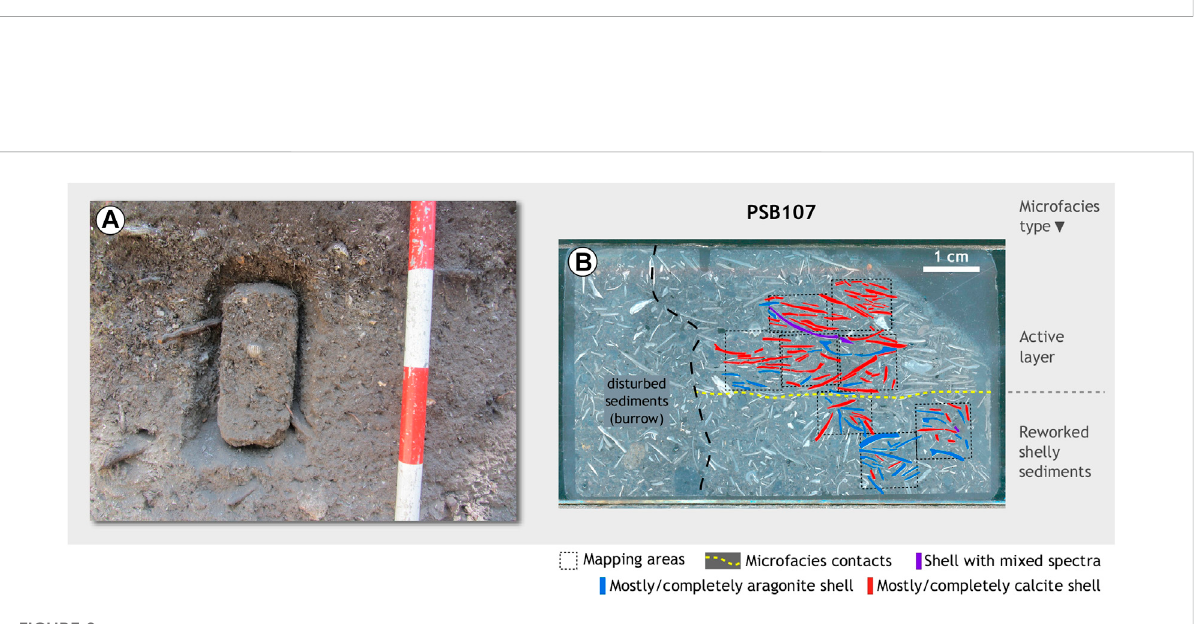
FIGURE 9 Sample PSB107. (A) Field photograph of the sample in pro fi le, prior to block extraction; note the general homogeneity that the shelly deposit exhibitsinthe fi eld,thoughdifferentdepositionalandpostdeposionaleventsarerevealedbymicrostratigraphyandmineralogy. (B) Thinsectionscan with individual shells ’ overall mineralogy obtained through micro FTIR.